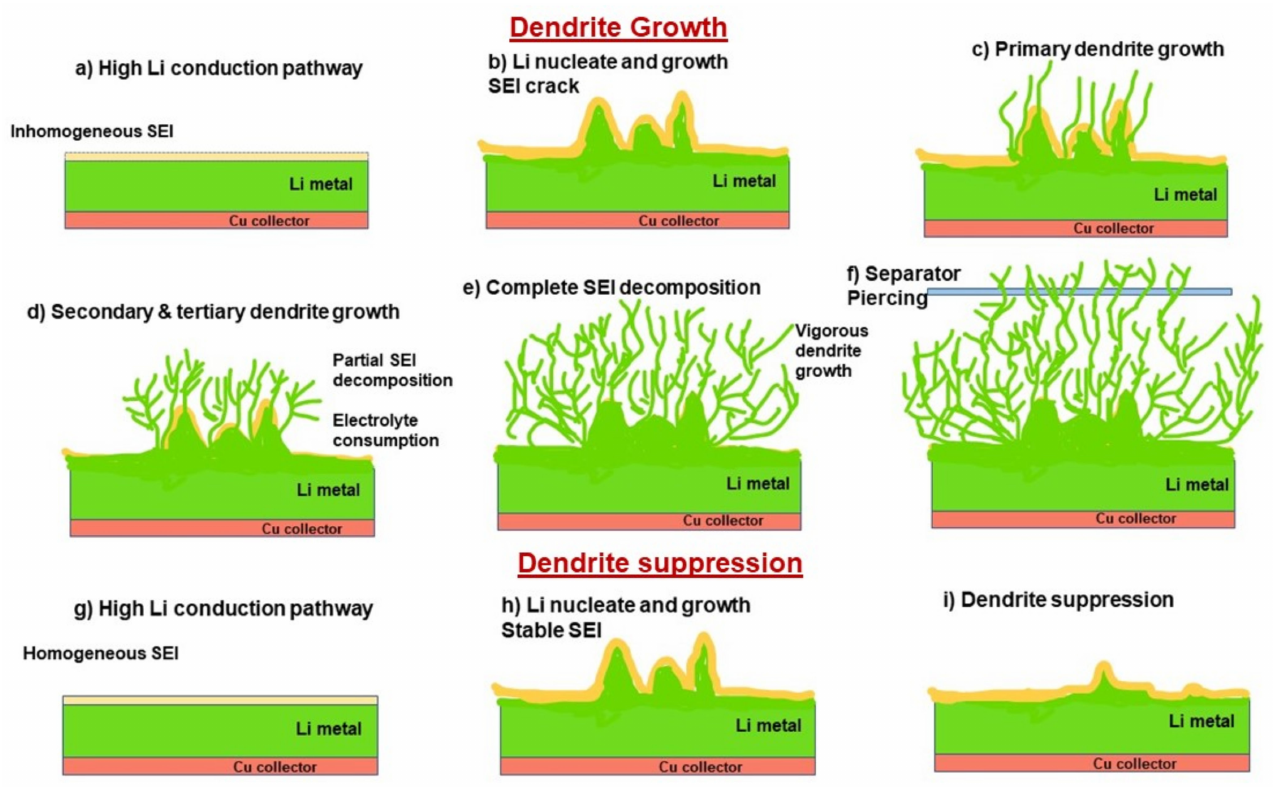
Figure 17. ( a – f ) Dendrite growth steps. ( g – i ) Suppression of dendrites due to stable SEI. In LIBs, the electro-reduction potential of the electrolyte medium is below 1.0 V vs. Li/Li + . Even with the exposure of bare lithium to organic solvents, rapid interactions between Li + and the electrolyte ions take place, forming insoluble by-products that are deposited onto the lithium surface. The components and the composition of the SEI layer vary with the electrolyte used and its concentration. The reaction rate occurring at the electrode–electrolyte interface depends on the velocity and ionic concentrations. Most of the inorganic decomposition products in Li-based batteries that deposit as the SEI are LiF, Li 2 O, Li 2 CO 3 , LiCl, LiOH, and organic groups such as POLi, PCOOLi, POCOLi, PCOO 2 Li, and POCO 2 Li; P = alkyl groups [196,197]. A mixture of decomposition products is formed because the electrolytic solution in alkali batteries contains a combination of chemicals to satisfy the following parameters: (i) high ionic conductance, (ii) low viscosity, (iii) high stability, and (iv) low flammability. As mentioned previously, depending upon the components of the electrolyte, the SEI composition varies. For example, while using LiPF 6 salt with organic carbonate as the electrolytes, the majority of the SEI film contains LiF and PF 5 [197]. While using non-combinational EC, C 2 H 5 COOLi and lithium carbonate (Li 2 CO 3 ) were found to be the main components of SEI. The smoothness and uniform depositions of the SEI improve with EC/PC in dioxolane (DOL), especially with sulfur cathodes. Jingling Zhou and co-workers reported high coulombic efficiency without dendrites using LiFSI and dibutyl ether (DBE) in Li–sulfur batteries [198]. Dendrite growth can also be controlled by altering the external and internal cell parameters, such as temperature, pressure, surface energy, and